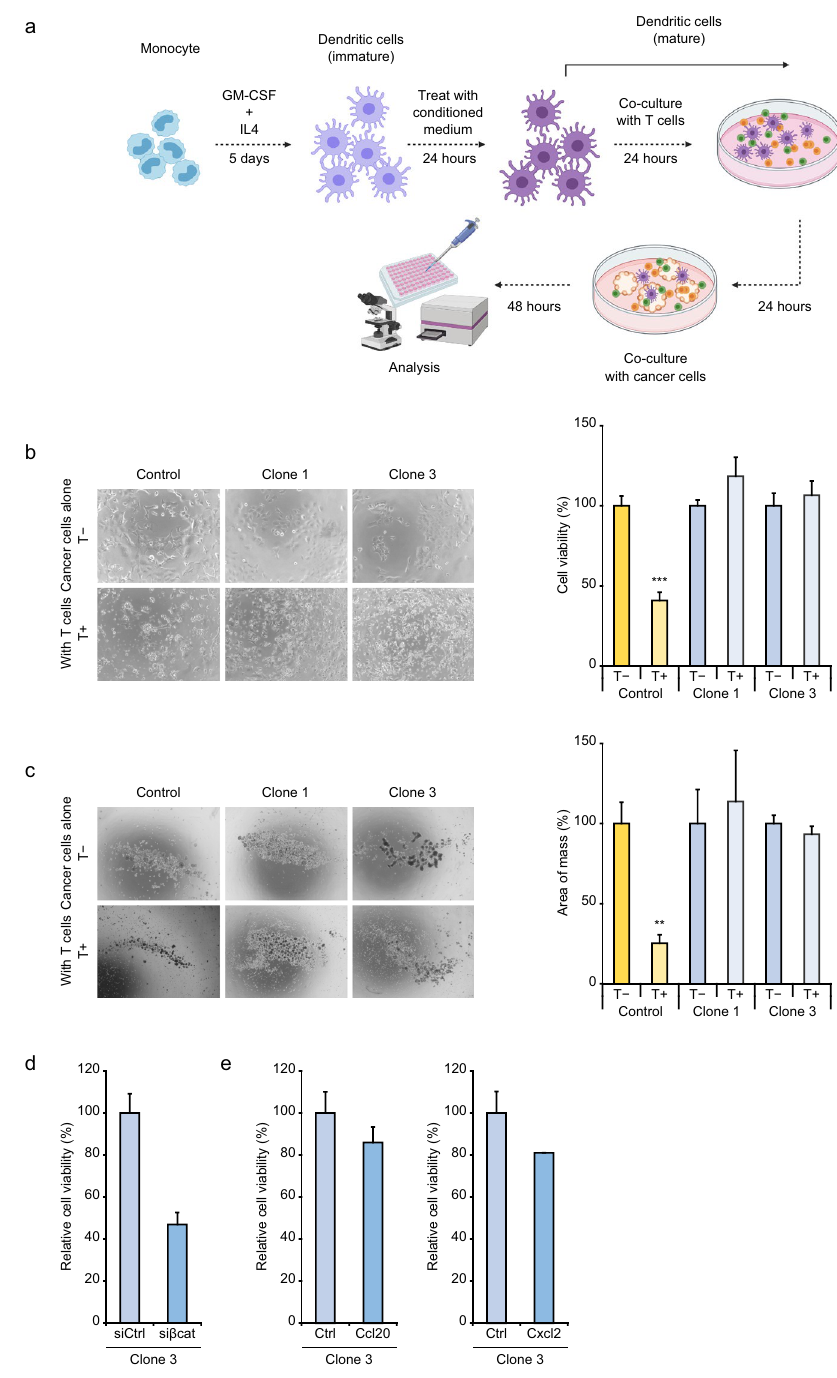
Figure 6. Immune evasion of mouse HCC cells with β-catenin signaling activation. ( a ) Schematic representation of in vitro T cell killing assays. ( b , c ) Two- and three-dimensional T cell killing assays of the 3H3-Ctnnb1 Δex3 cells. The left and right panels show representative phase-contrast images and cell viability data, respectively. Error bars are the mean ± SD. P -values were calculated by Welch’s t test. ** P < 0.01; *** P < 0.001. ( d ) and ( e ) Three-dimensional T cell killing assays of the β-catenin-knockdown and cytokine-expressing 3H3-Ctnnb1 Δex3 cells, respectively. Error bars are the mean ±